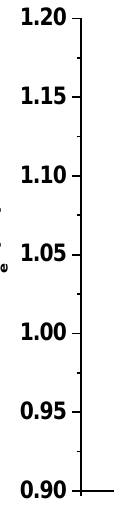
Figure 4. Mean value and fluctuations of the plasma parameters over all samples (error bars represent average standard deviation of evaluated T e and N e ).